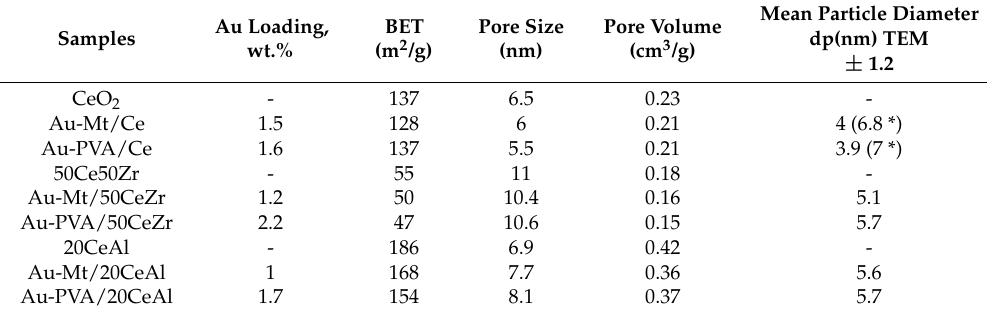
Table 1. Catalysts metal loadings and structural